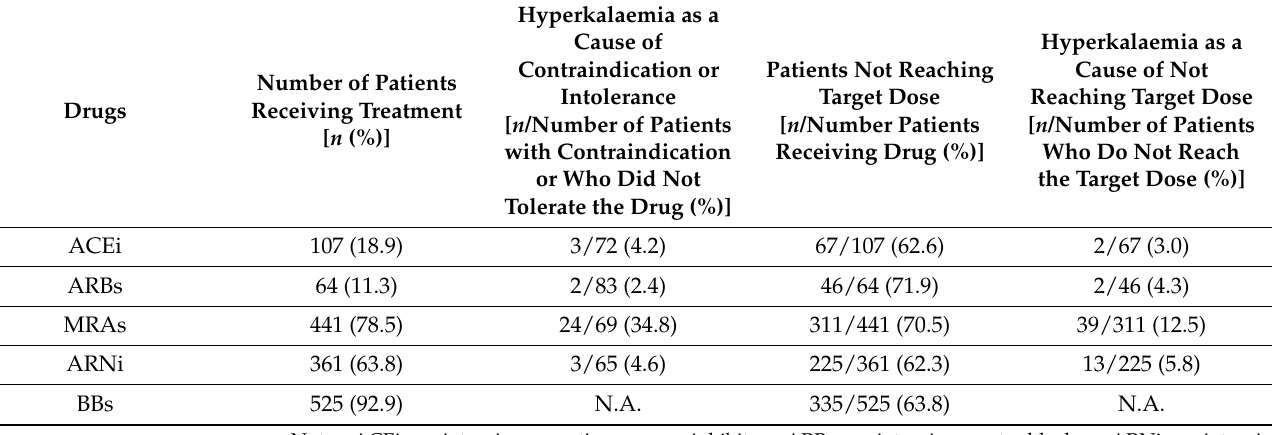
Table 4. Specific drugs for the treatment of HFrEF and the importance of hyperkalaemia as the reason for not administering or reaching a target